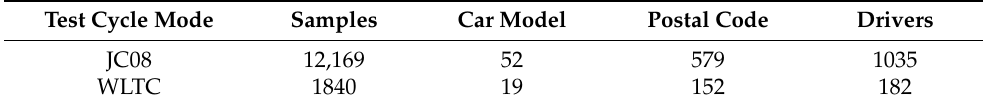
Table 1. Number of samples, car models, postal codes, and